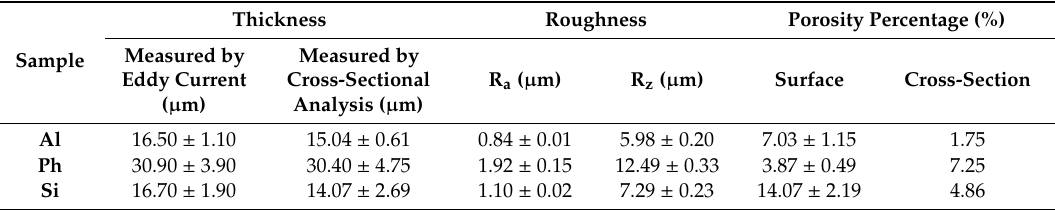
Table 2. Porosity percentage, thickness, and roughness measurements of Al, Ph, and Si specimens.